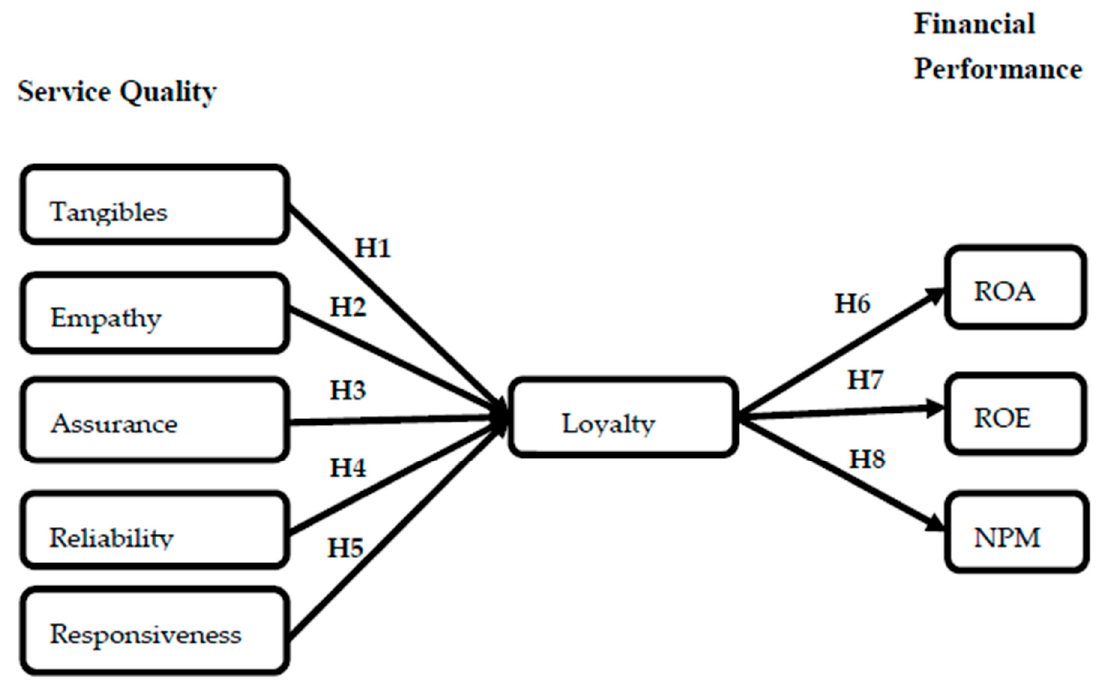
Figure 1. Conceptual framework of the study.